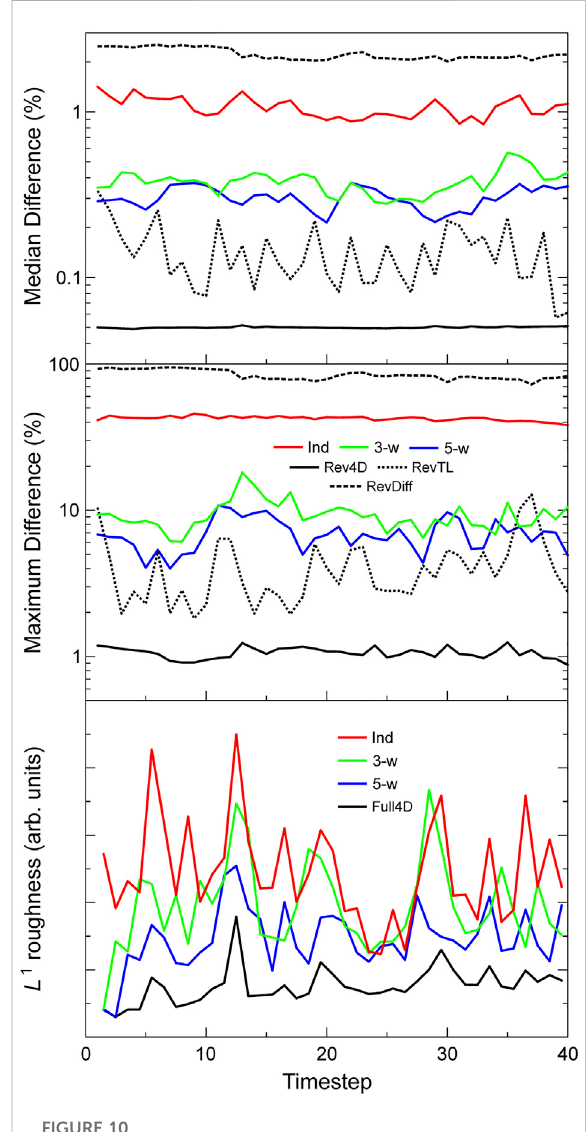
FIGURE 10 Quantitative measures of consistency for each of the inversion methods. Top: median differences between the forward full sequence 4D inversion and the independent, windowed and reverse full sequence 4D inversions, and between the forward and reverse time-lapse inversions, and between the forward and reverse difference inversions. Middle: respective maximum differences. Bottom: L 1 measures of the temporal roughness of the independent, windowed and full sequence 4D